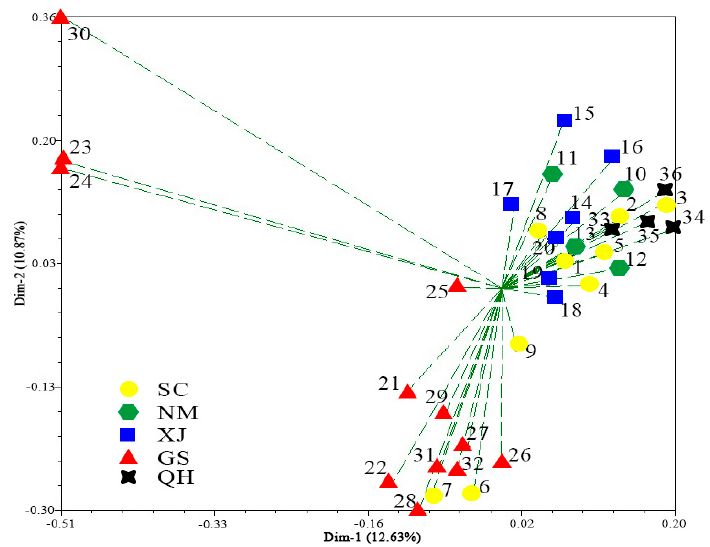
Figure 3. Principal coordinates analysis for the first and second coordinates estimated for EST-SSR markers using Jaccard ′ s genetic similarity matrix for 36 E. sibiricus accessions.